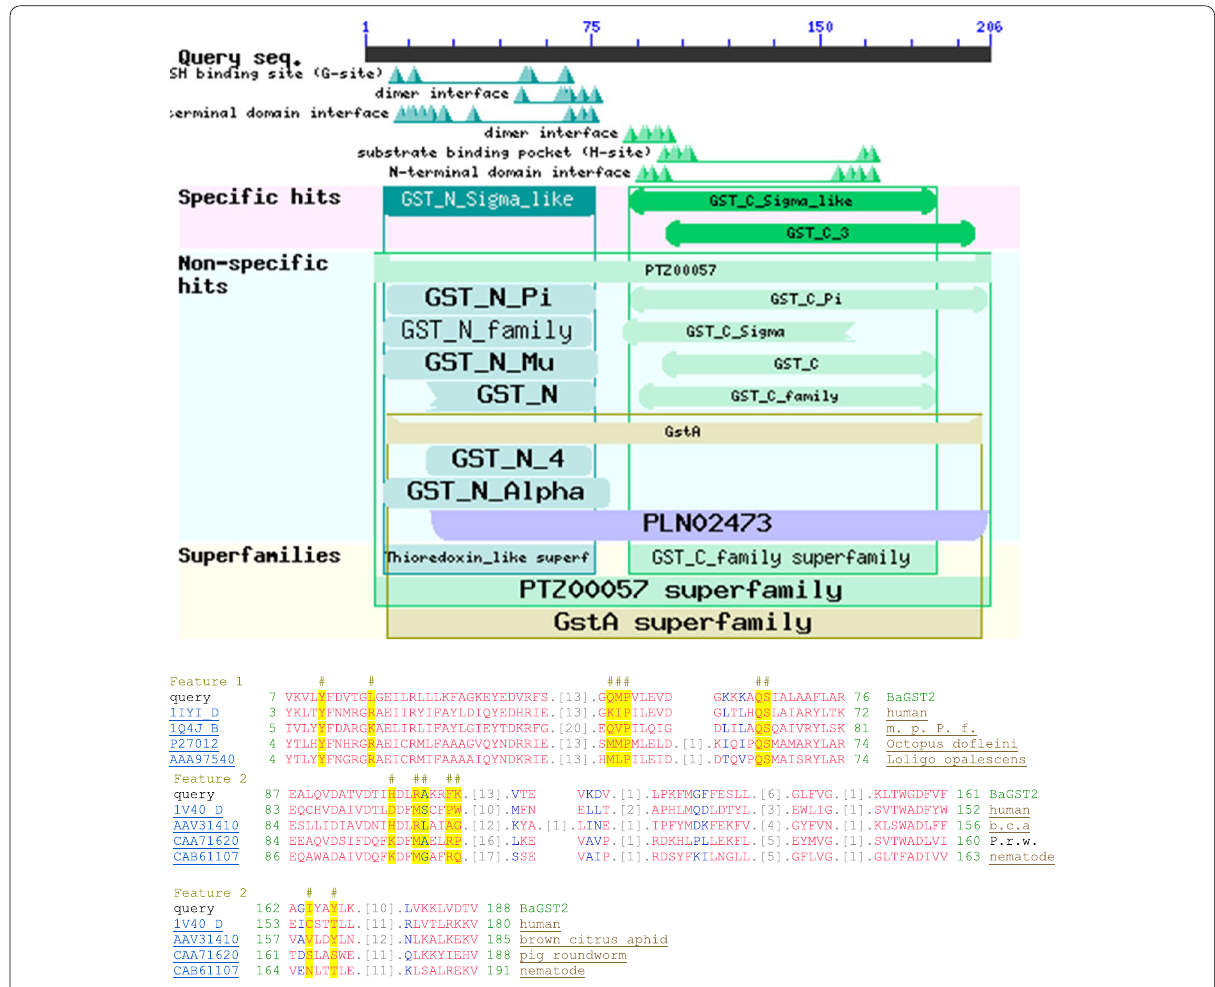
Fig. 6 Conserved domains search of BaGST2. Conserved domains were identified by the tool of the CD‑Search based on the conserved domain database (CDD) (https:// www. ncbi. nlm. nih. gov/ Struc ture/ cdd/ wrpsb. cgi). The G‑site binding moieties are denoted by # in feature 1, and H‑site binding moieties are denoted by # in feature